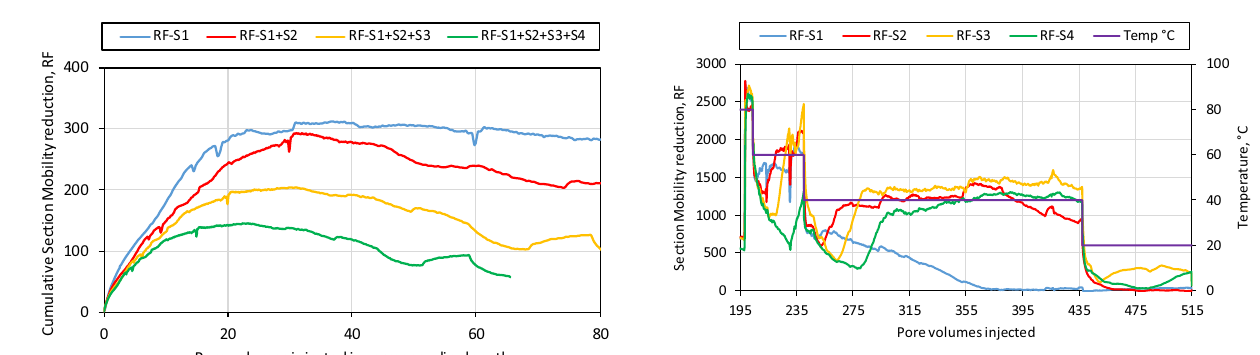
Fig. 18 Experiment 7, 1000 ppm A10 in SSW in 76 cm sand column. Cumulative RF pm as a function of pore volume cumulated over the corresponding length. The volumetric injection rate is 3.0 ml/min